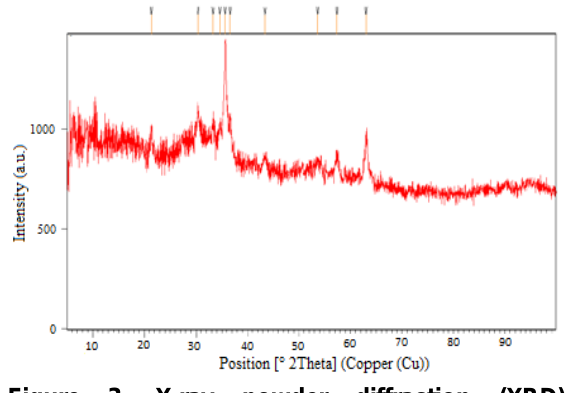
Figure 3. X-ray powder diffraction (XRD)